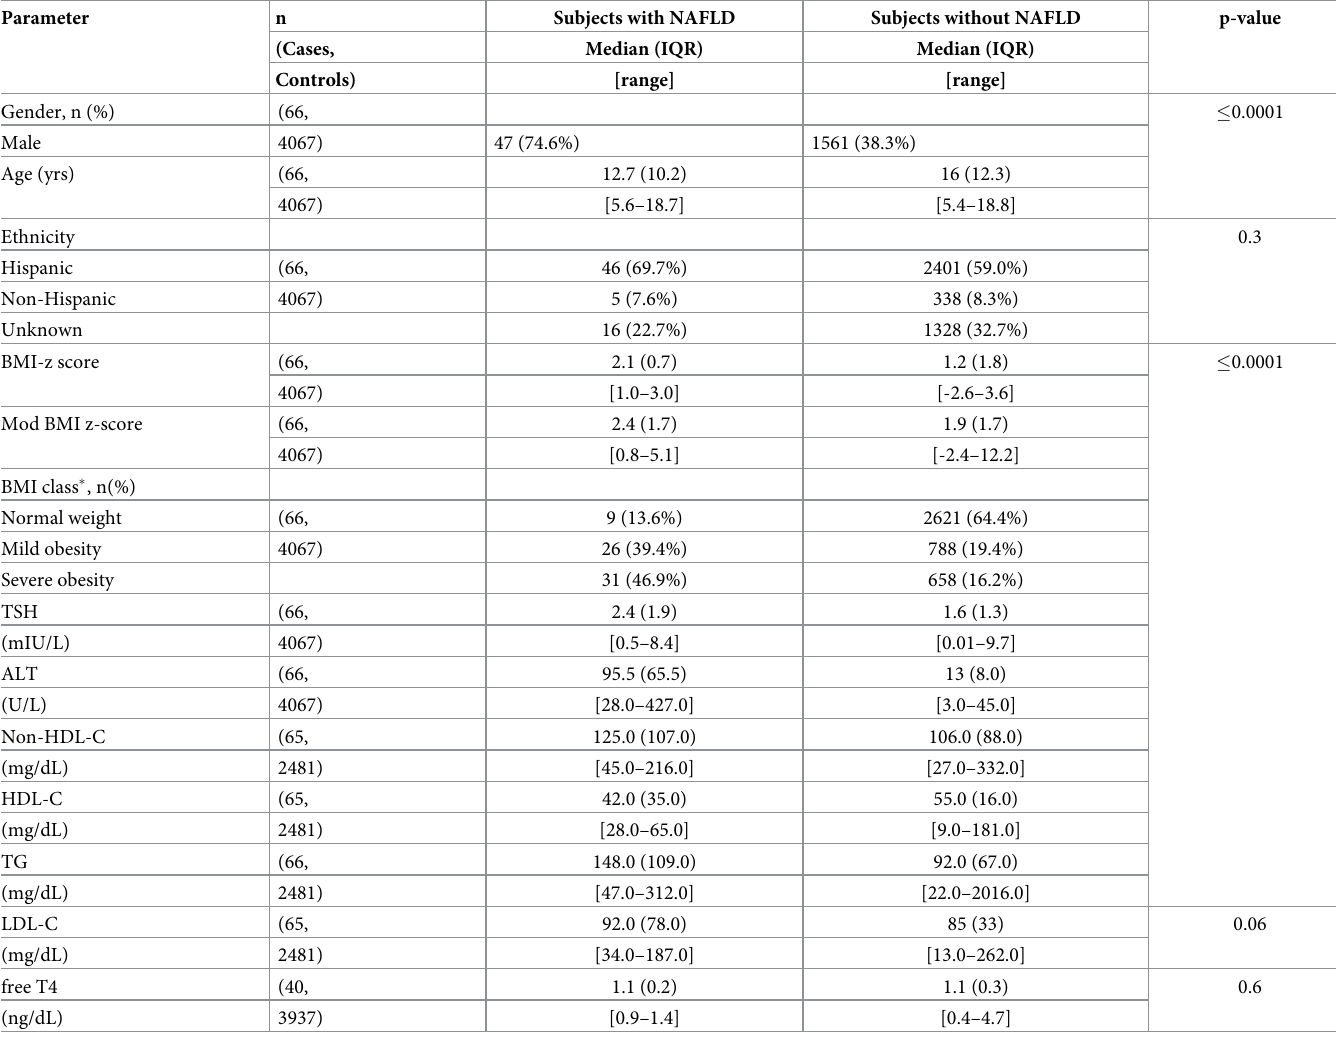
Table 1. Demographic distribution of the cases and